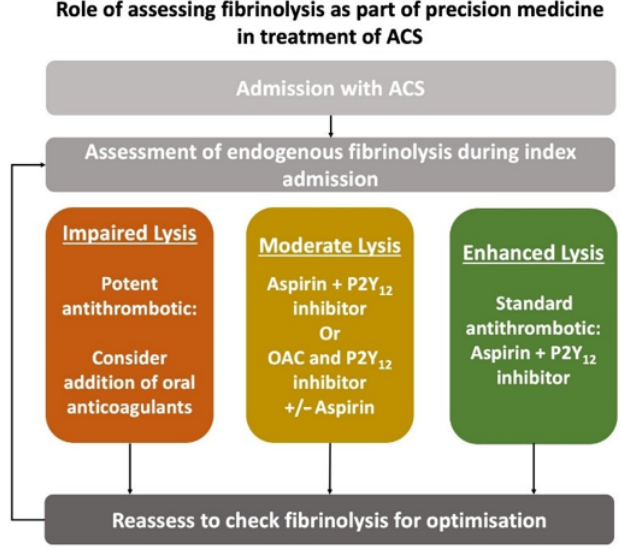
Figure 1. Proposed algorithm for assessing endogenous fibrinolysis in patients presenting with acute coronary syndrome (ACS). OAC: Oral anticoagulants.